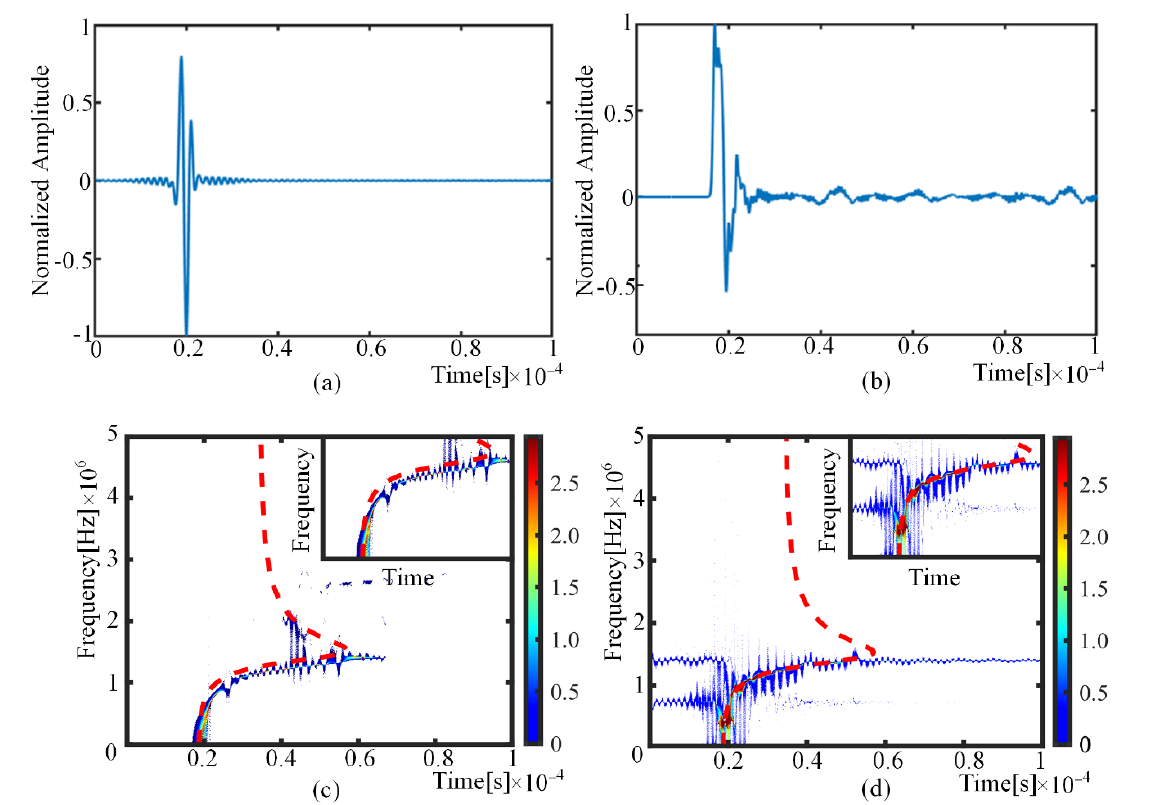
Figure 6. Sensor waveforms of finite element simulation and analytical prediction: ( a ) the analytical modeling result (time domain); ( b ) the finite element simulation results (time domain); ( c ) the analytical modeling result (short-time Fourier transform); ( d ) the finite element simulation results (short-time Fourier transform).